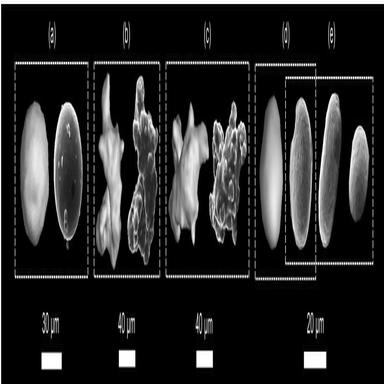
Comparison of images collected on the same particle using CT (left) and SEM (right), for different materials: Ti6Al4V (a), AlSi10 (b,c) and CuCrZr (d). Comparison of SEM images of the same CuCrZr particle taken at three different perspectives (e).